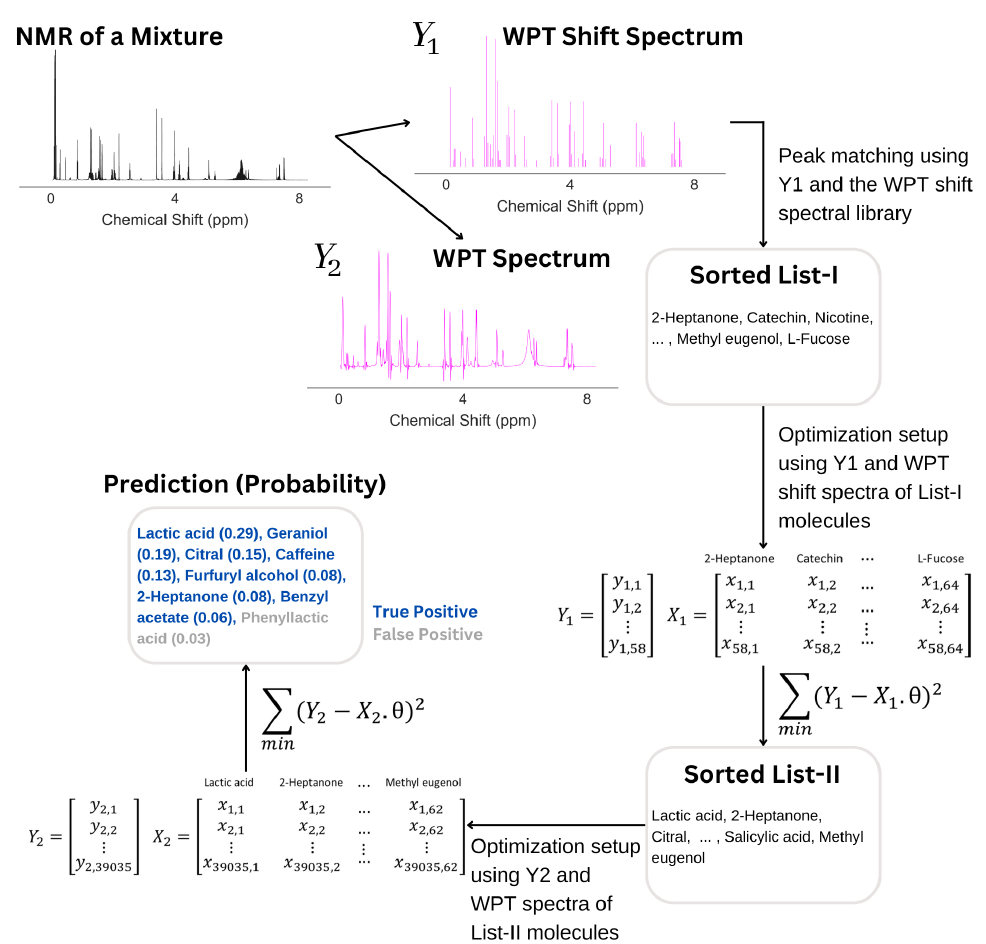
Figure 8. An illustration of how an NMR spectrum is analyzed in predicting the corresponding mixture composition. After calculating the WPT shift ( Y 1 ) and WPT ( Y 2 ) spectra from the NMR spectrum, an automated sorting selected 64 molecules (List I) from the library of 74 molecules by matching the WPT shift spectral peaks of Y 1 and that of the pure molecules from the library. An optimization of List I followed, yielding List II with 62 molecules. Another optimization of the top 15 entries from List II produced the final prediction, containing 8 molecules, with 7 of those corresponding to the true molecular composition of the